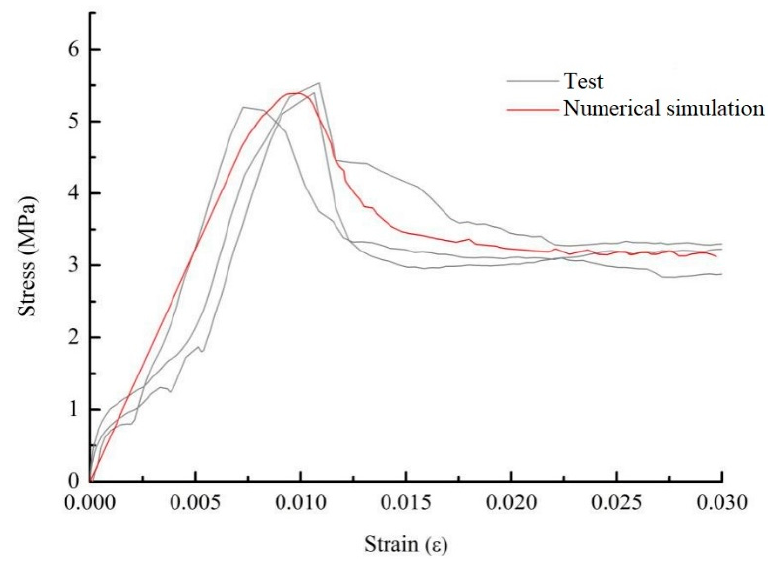
Figure 18. Stress-strain curves of numerical simulation and test. Figure 19 shows the damaged specimen after loading, the failure state of the specimen in the corresponding numerical model, and the inside crack development of that. The fail- ure of foam concrete occurred in the lower left of the sample, and penetrating oblique cracks were formed in the test or numerical model, which is a typical failure mode of concrete materials. In Figure 19c, the circular pie shape represents the microcracks, and the genera- tion mechanism is as follows: when the stress between particles is greater than the limit tensile stress or shear stress that the bond can withstand (that is, Equations (8) and (10) are satisfied), the program defaults that the bond breaks here and then marks the damage with the circular pie shape, and indicates whether it is a shear failure (shearFail) or tensile failure (tenFail). Therefore, it can be seen from the fracture mode that the tensile failure produces more cracks than the shear